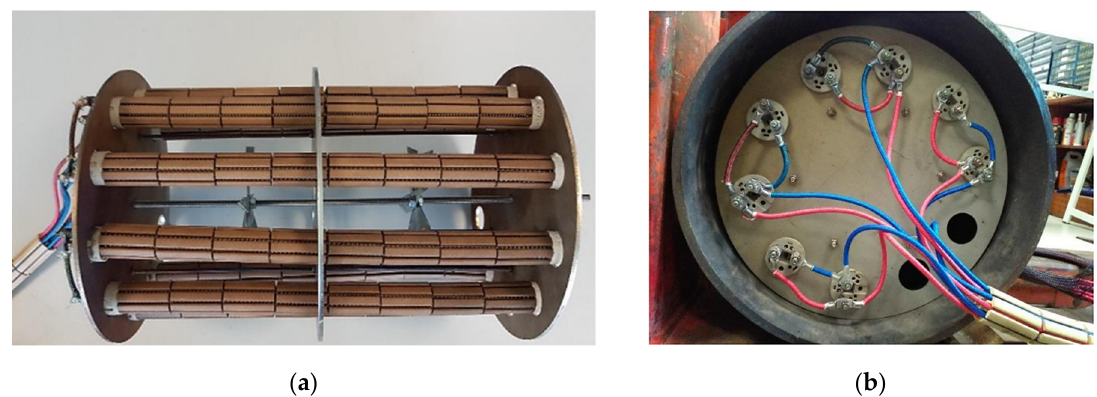
Figure 2. ECT system Validation: ( a ) automated inspection system coupled with ECT probes while performing a scan along the pipe perimeter; ( b ) thermographic image with temperature represented in degrees Celsius (°C).